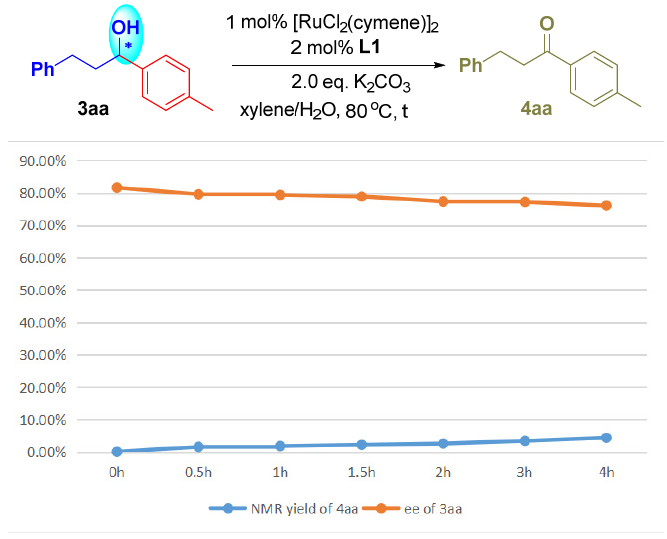
Scheme 8. Plots for relationship of time, enantioselectivity and ketone